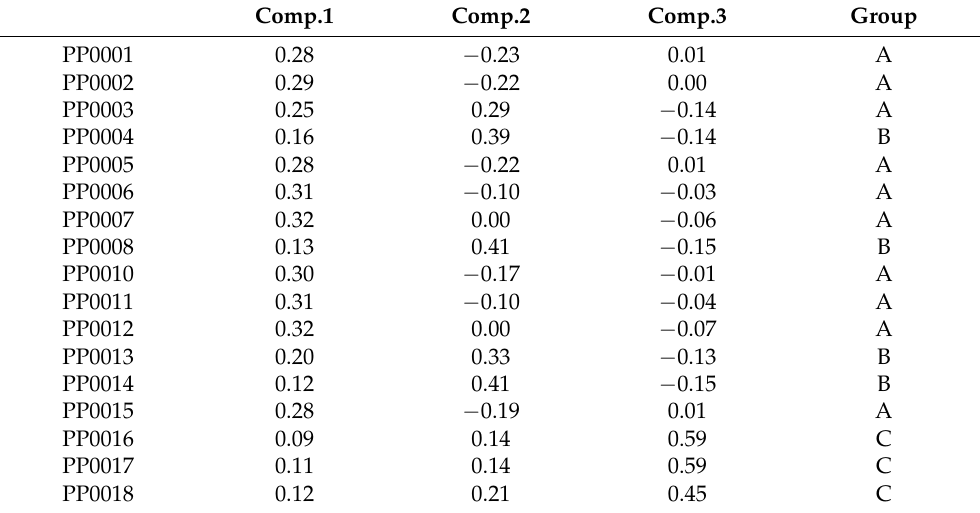
Table 3. Coefficient matrix for component scores and group distributions for porewater pressures.